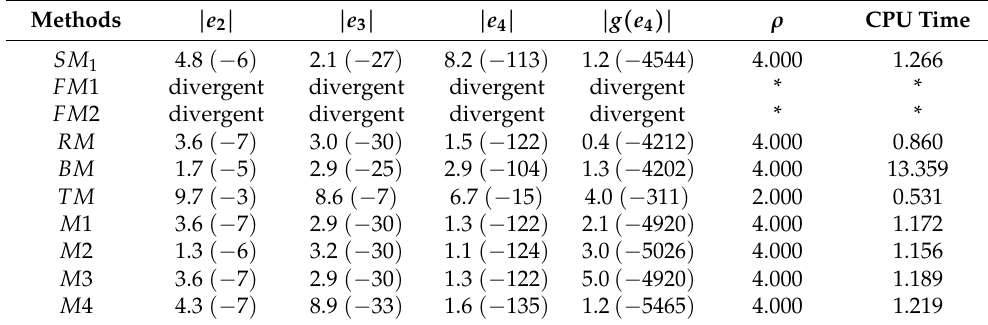
Table 8. The outcomes of Example 5 on various